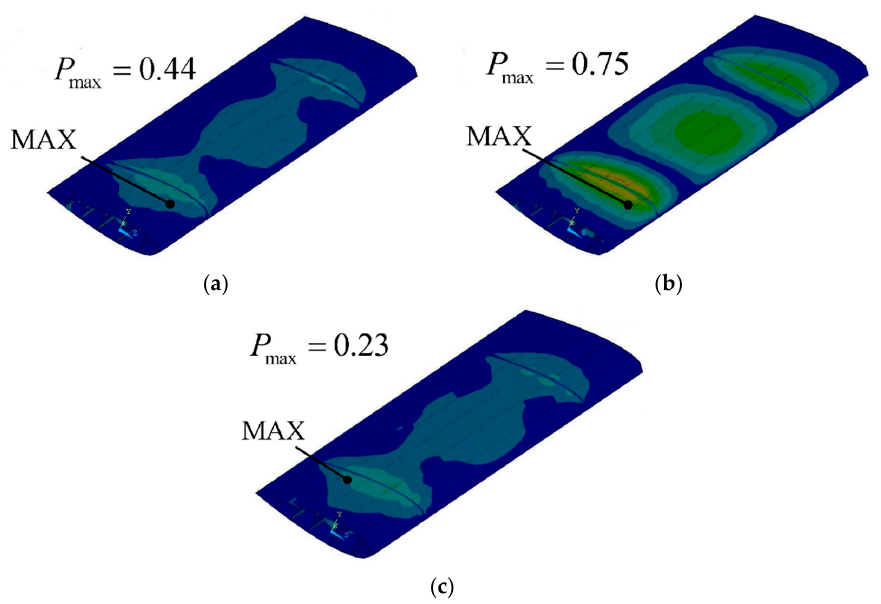
= 0.44); ( b ) Second lamina ( P = 0.75); ( c ) max max